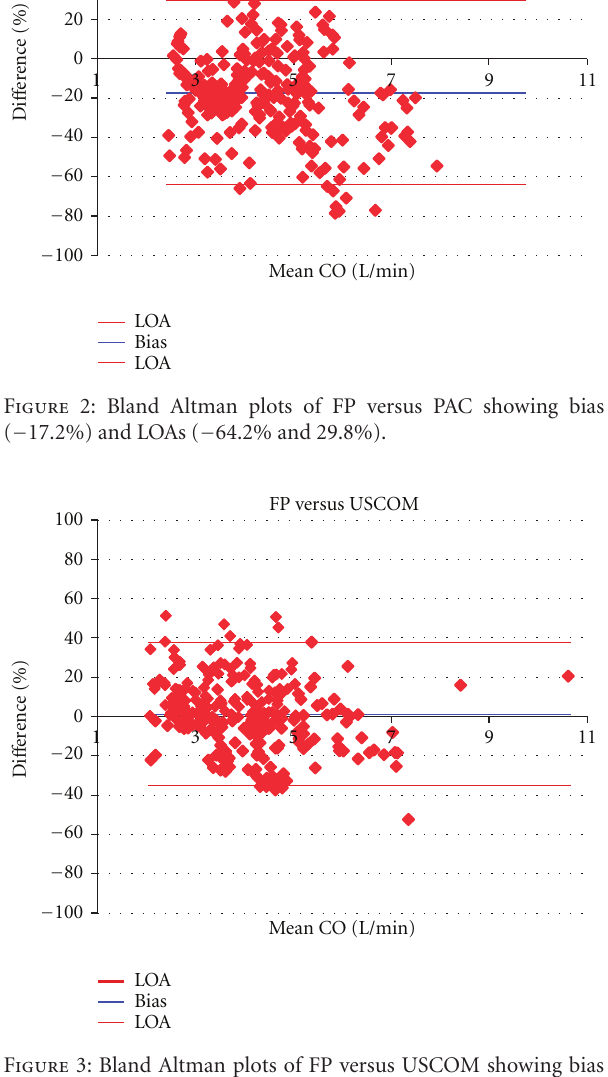
Figure 3: Bland Altman plots of FP versus USCOM showing bias (1%) and LOAs ( − 35.3% and